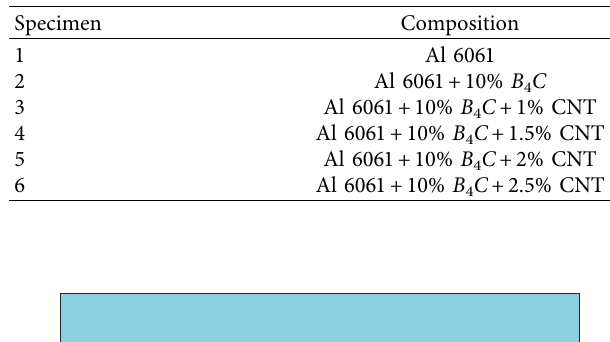
Table 2: Al 6061 and hybridized reinforcement (MWCNT + B with variant